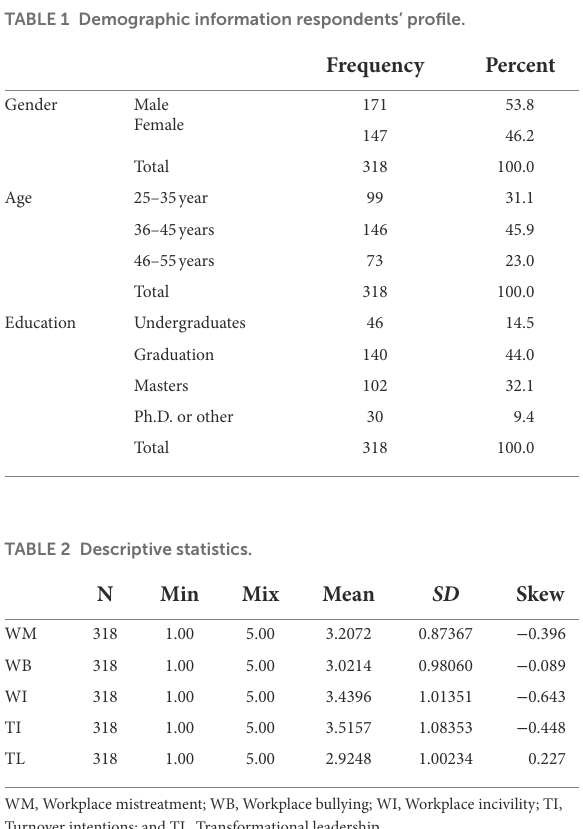
TABLE 1 Demographic information respondents’ profile.